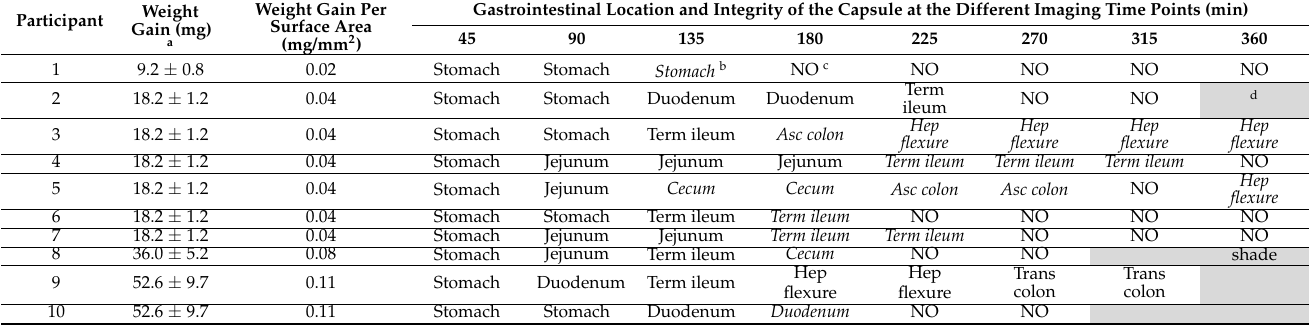
Table 2. Summary of the specifications of the capsules administered to the healthy human participants and their location and integrity in the gastrointestinal tract at different time points post